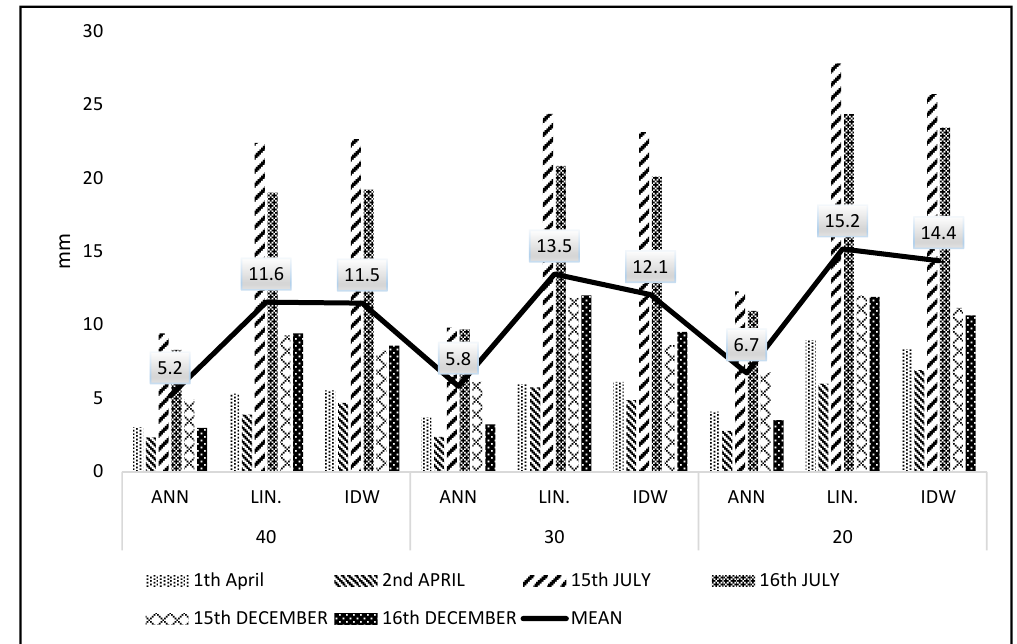
Figure 5. RMSE values for ANN-LIN-IDW methods.